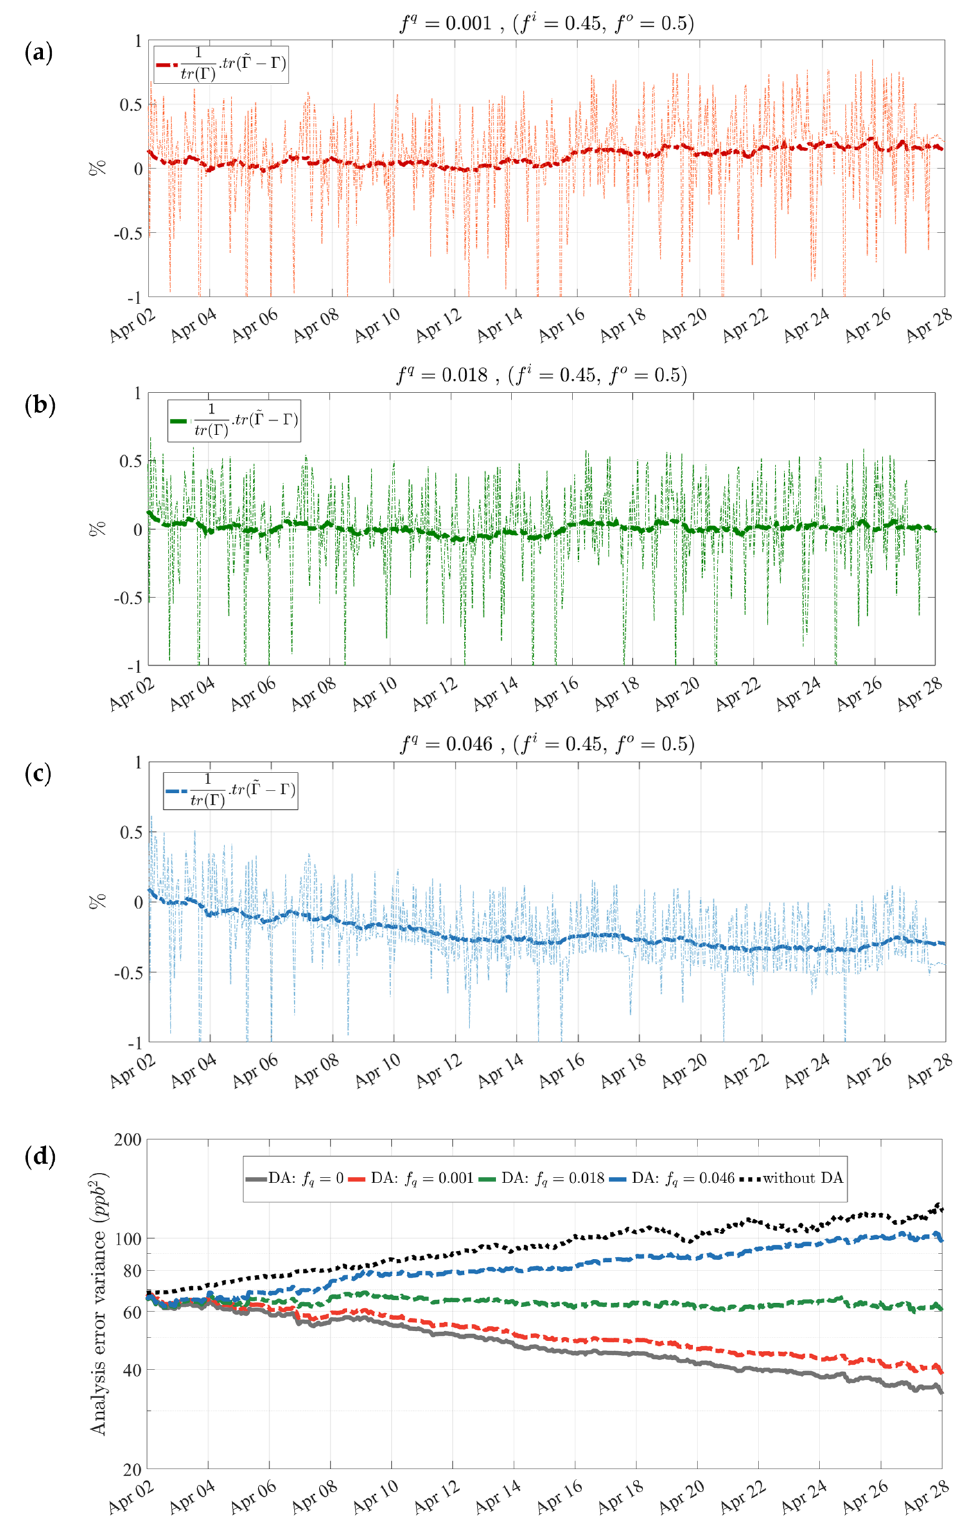
Figure 5. Normalized innovation variance consistency diagnostic for a ( a ) low ( q f = 0.001), ( b ) proper ( q f = 0.018), and ( c ) high ( q f = 0.046) model error parameter value. ( d ) indicates the effect of model error on analysis error variance over time.